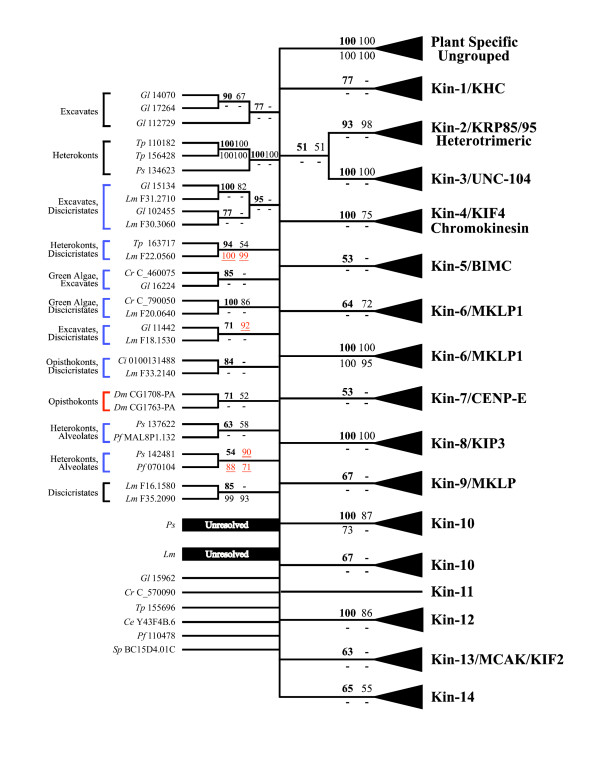
Unrooted Bayesian tree of the 529 kinesins based on their motor domain ami no-acid-plus-gap-characters. Support values from each parsimony and Bayesian analysis are presented adjacent to the nodes. Support values above each branch correspond to Bayesian posterior probabilities whereas values below each branch correspond to parsimony jackknife support. In both cases the leftmost values are for the amino-acid-plus-gap-characters analyses and the rightmost values are for amino-acid-characters analyses. Bayesian posterior probabilities for the amino-acid-plus-gap-characters are also shown in bold. If a branch was unresolved in one of the other three analyses, it is indicated by "-" at the respective node. If a branch was contradicted in one of these other three analyses, it is indicated by underlined red font at the respective node with the single highest posterior probability or jackknife support value for the contradicting clade(s) shown. Ungrouped kinesins are presented on the left side of the main polytomy, with the exception of the plant-specific ungrouped family that is shown on the upper right of the tree. The Ps and Lm unresolved blocks each contain 4 and 9 sequences, respectively (See Additional files 7 and 11 these sequence IDs). Brackets denote the major eukaryotic groupings in accordance with Baldauf's nomenclature [50]. Blue brackets indicate taxa that are from multiple groups, black brackets indicate protozoan species and red brackets are reserved for opisthokonts. Although Pt00151235 is grouped within this family by Bayesian analysis, we favor the parsimony resolution of it as a member of the Kinesin-10 family. For full names of species see Fig. 1 legend.